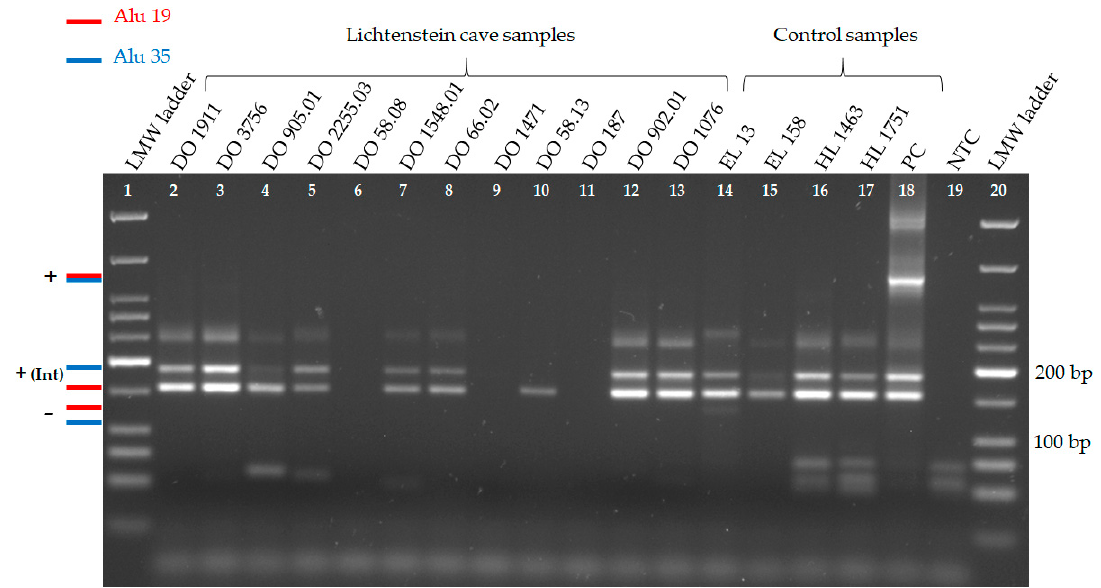
Figure 3. Gel electrophoresis of Alu duplex 2, containing Alu 19 and 35 in twelve Lichtenstein cave samples and five control samples. Apart from the positive control samples, fully informative results of Lichtenstein cave samples can be seen in lanes 2–5, 7–8 and 12–13. Amplification results of Alu 19 are visible in 10 out of 12 Lichtenstein cave samples (lane 2–5, 7–8, 10 and 12–13). On the left in red and blue is the expected length of each possible amplicon. The insertion (+) of an Alu element is shown by the internal (Int) fragment. Some samples show weak unspecific bands longer than 200 bp. On the right is the modern DNA positive control sample (PC), the negative control sample (NTC), and the LMW ladder. The gel ran at 100 V for 90 min and had a UV light exposure time of 1.20 s. (Up to now, no absence bands for Alu duplex 2 were amplified. Thus, an Alu ladder could not be constructed). In general, amplification success decreases with increasing degree of DNA degradation.